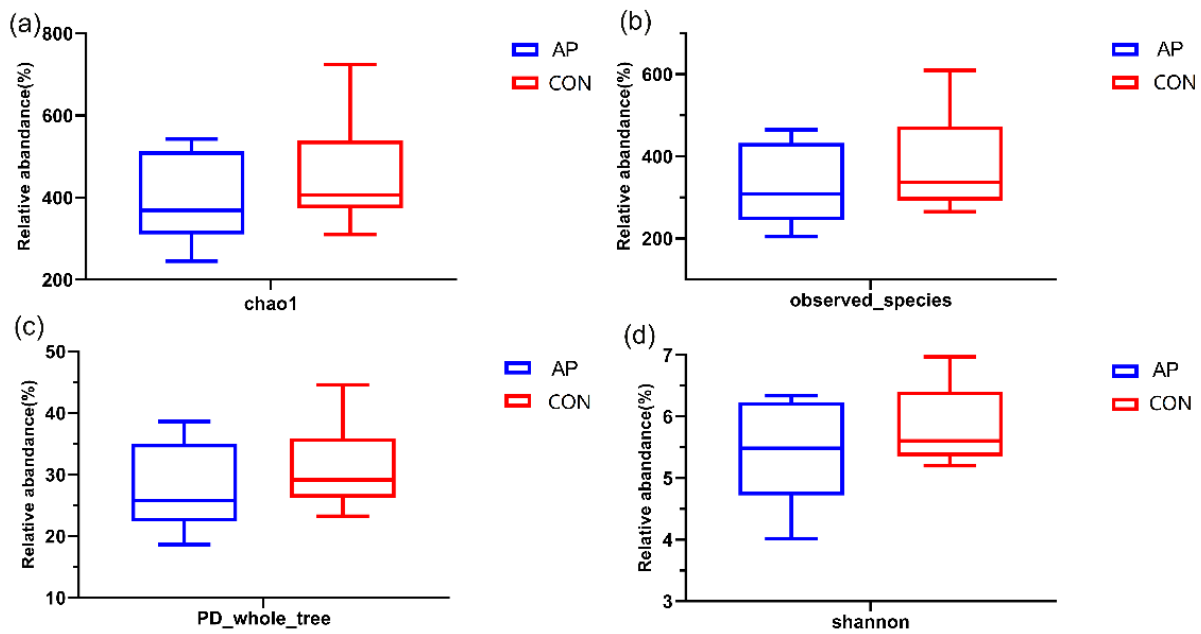
Figure 1. Effects of Apple pomace (AP) on intestinal microbial alpha diversity index: ( a ) chao1, ( b ) observed_species, ( c ) PD_whole_tree, and ( d ) shannon index. CON: control group; AP: Apple pom- ace.